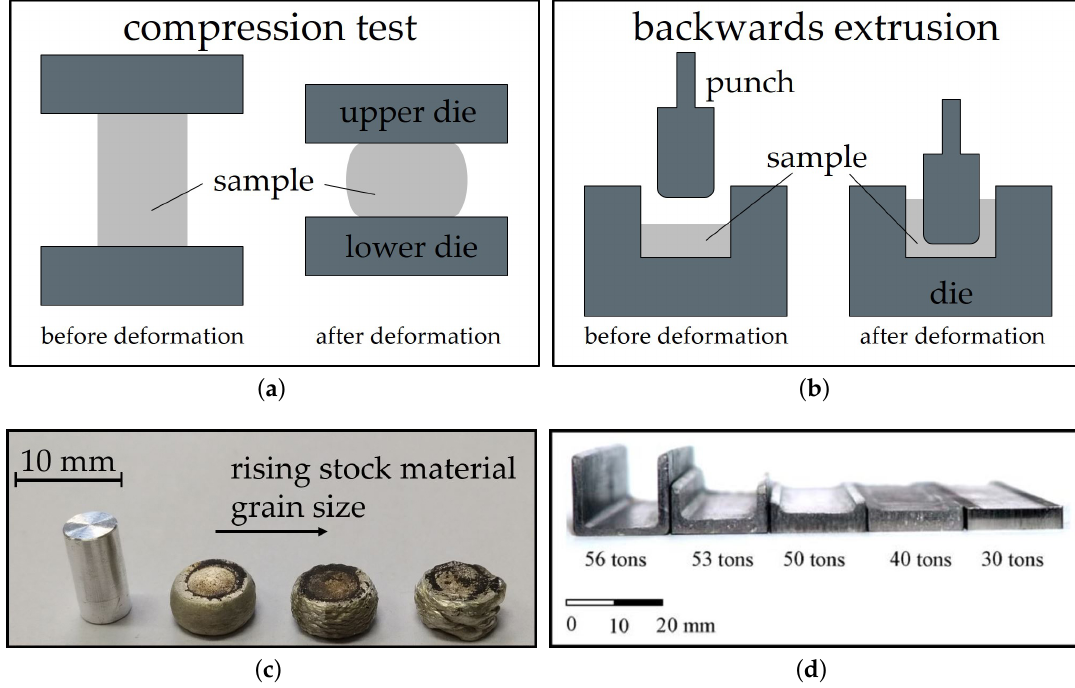
Figure 2. Schemes of simplified testing set-ups for ( a )compression testing and ( b )backwards extrusion; ( c )AXM lean alloy compression samples with varying stock material grain sizes tested at 400 ◦ C. Picture( d ) shows parts manufactured from AZ31 by backwards extrusion at 250 ◦ C with varying forming load [29], reproduced with permission from